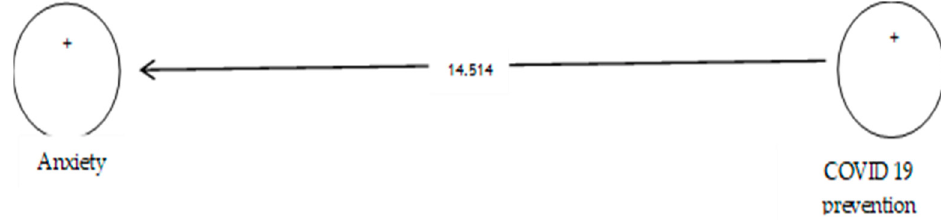
Figure 9. Drawn model with significant coefficients z.